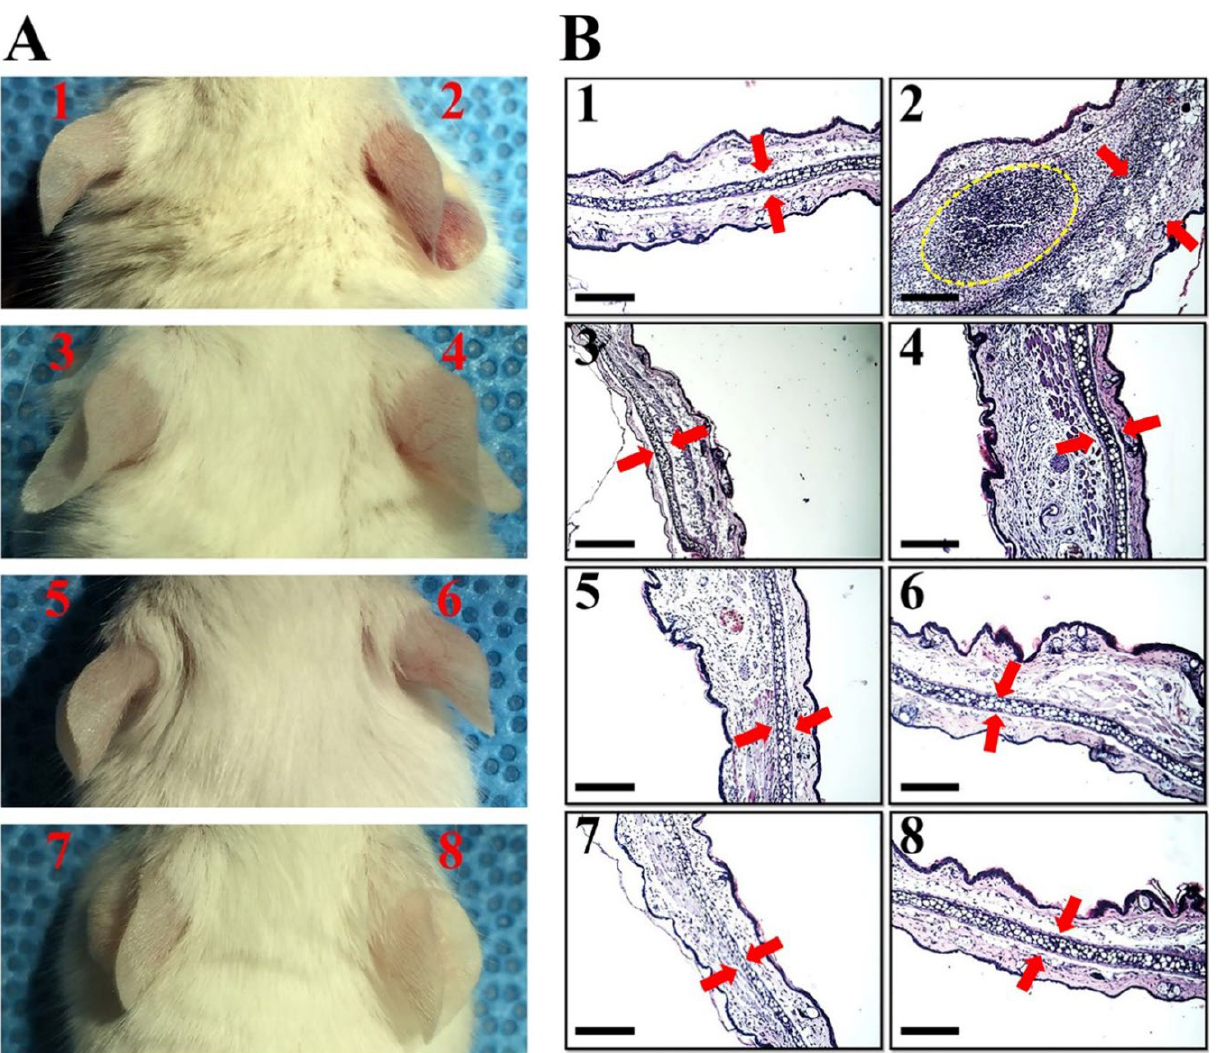
Figure 7. Anti-inflammatory effects of peptides on LPS-induced ear edema. ( A ) The ears of Balb/c mice ( n = 3) were injected intradermally with LPS solution (0.02 µ g). After 1 h, the indicated peptides were injected in 32 µ M, followed by further incubation for 3 days. ( B ) Ear morphologies were digitally recorded, and collected ears were stained using hematoxylin and eosin (H&E) on paraffinized